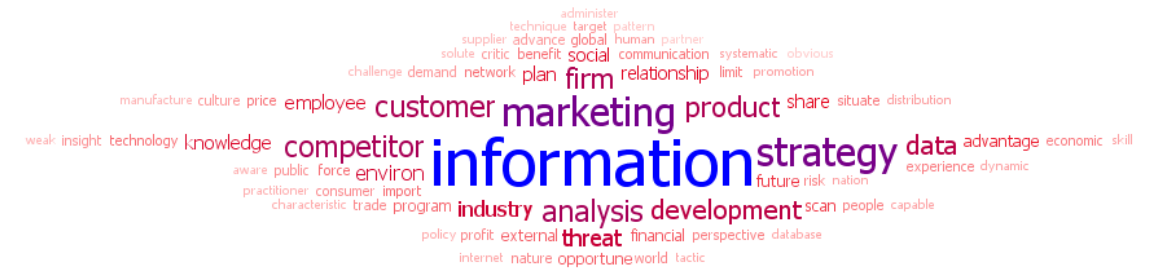
Figure 3. Word cloud of second cluster.